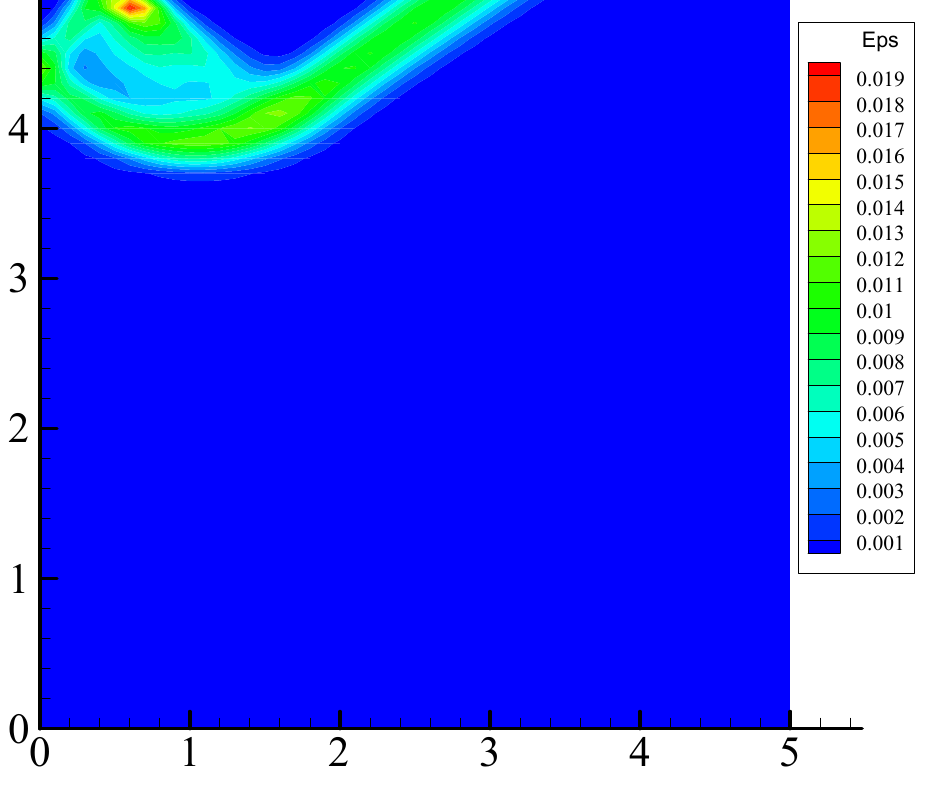
Figure 5. Equivalent plastic strain at the failure load.